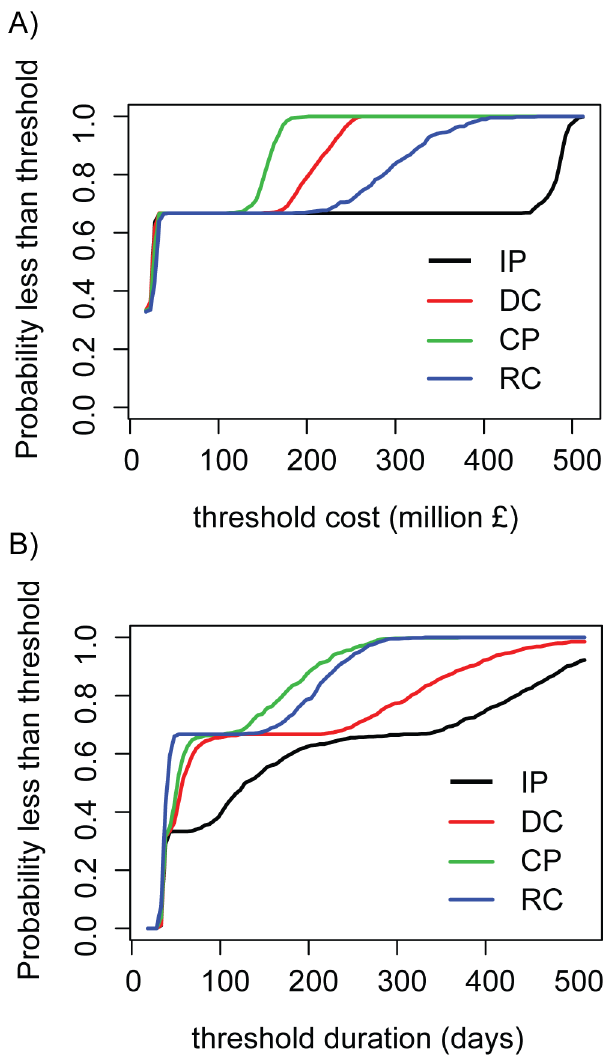
Figure 4. The probability of FMD epidemic outcomes below a stated threshold for the four nested alternative management tactics. (A) Outcomes for the management objective to minimize total epidemic cost due to livestock loss assuming equal weights on the three kernel models. (B) Outcomes for the management objective to minimize the duration of management activities, again assuming equal weights on the three kernel models. The x-axis indicates the cost (in millions of pounds) or duration (days) threshold that managers would like to stay below. The y-axis indicates the probability, averaged across all three kernel models, of outcomes below the threshold for each management tactic (solid lines). (Figure 4A versus 4B). We further describe analyses of alternative objectives in Text S1E.